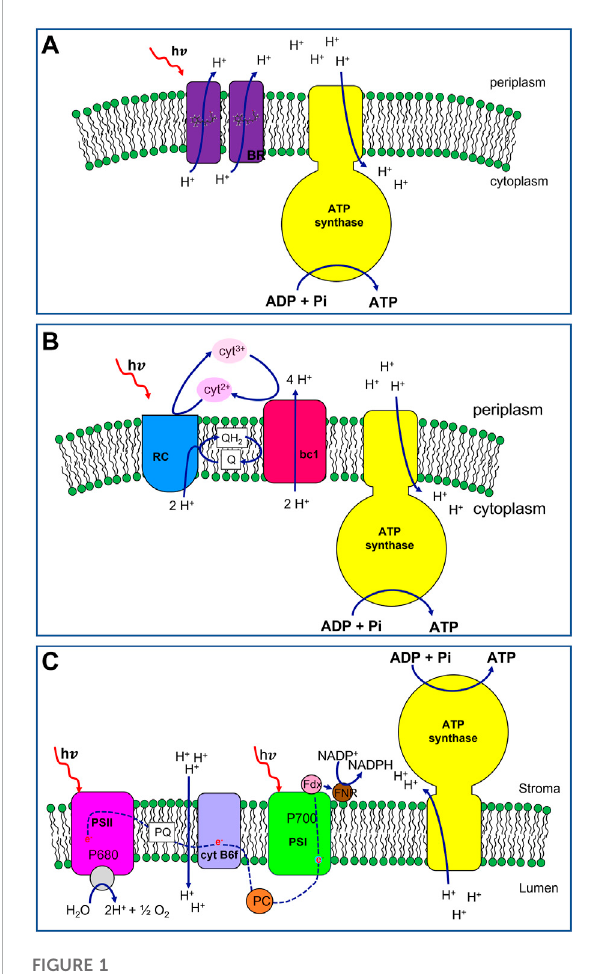
FIGURE 1 Schematic representation of photosynthetic apparats with increasing complexity belonging to Archea, photosynthetic bacteria and plant cells. (A) Halobacterium salinarium photophosphorylation machinery. Bacteriorhodopsin (BR, in purple) acts as light-driven proton pump. Upon light excitation, the chromophore, i.e., a retinal group embedded in each protein monomer, undergoes trans -to- cis photo-isomerization inducing a conformational change in the protein backbone. The all- trans original state is regained thanks to the outward movement of protons across the microbial membrane generating a proton potential. The pH gradient is used in the end to drive ATP synthesis by ATP synthase (in yellow). (B) Bacterial photophosphorylation machinery from Rhodobacter sphaeroides . Theprimarycomponentsoftheapparatusare:ReactionCenter(RC,in blue), ubiquinol: cytochrome c oxidoreductase (bc1, in red), ATP synthase (in yellow). The bacterial photosynthesis starts with Light Harvesting Complexes (not shown) that absorb incident light and transfertheenergyto theReaction Center.RC catalyses togetherwith bc1, a cyclic redox reaction involving the two couples of electron shuttles: the periplasmic soluble protein cytochrome c2 in the reduced (cyt 2+ ) and oxidised (cyt 3+ ) form (in pink and light pink, respectively), and liposoluble quinone (Q)/quinol (QH 2 ) molecules (in white). During the photo-redox cycle, protons are translocated from the cytoplasm to the periplasm generating a pH gradient across the membrane. This proton-motive force is then exploited by the ATP synthase to synthetize ATP. (C) Plant chloroplast photophosphorylation machinery. The main components are 4 membrane protein complexes (i) photosystem II (PSII, in magenta), (ii) cytochrome b 6 f (in violet), (iii) photosystem I (PSI, in green), and (iv) ATP synthase (in yellow). Upon light absorption, PSII transfers